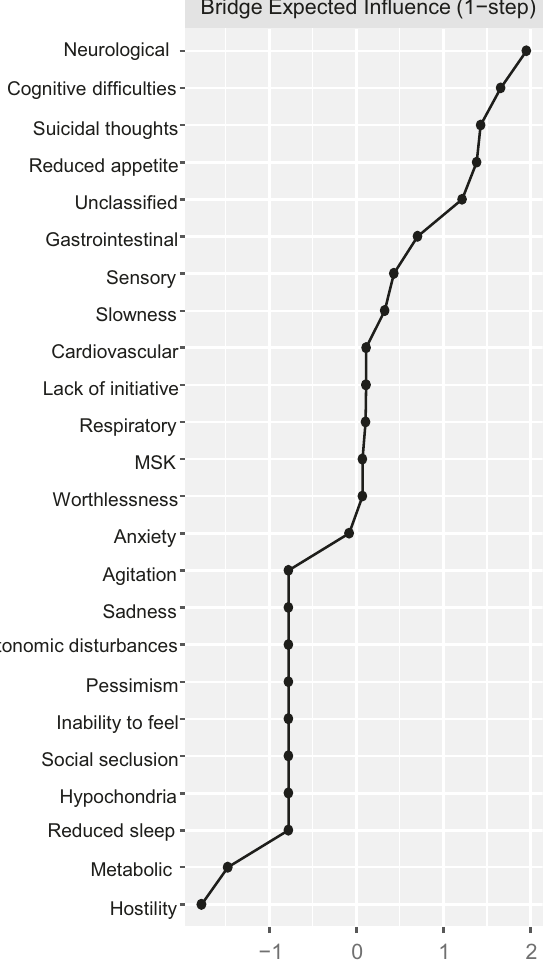
Fig. 3 Bridge centrality measures of the expected in fl uence of the network incorporating somatic disease clusters and depressive symptoms. Bridge expected in fl uence expresses a node ’ s connec- tivity with the other network. The higher the centrality, the greater the connection between a node of one network (e.g., depressive symptom) with the nodes of the other network (e.g., somatic disease